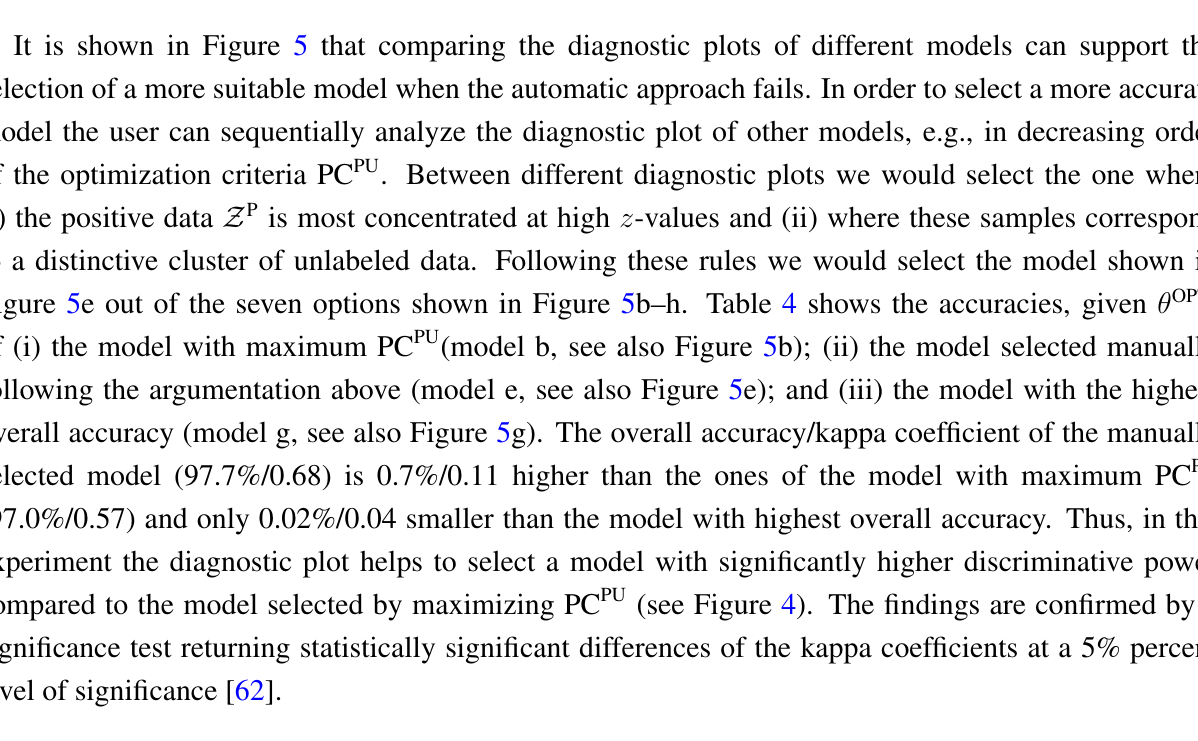
Table 4. Confusion matrices and accuracy measures given θ OPT for the model b selected by maximizing PC PU (b), the manually selected model (e), and the optimal model, in terms